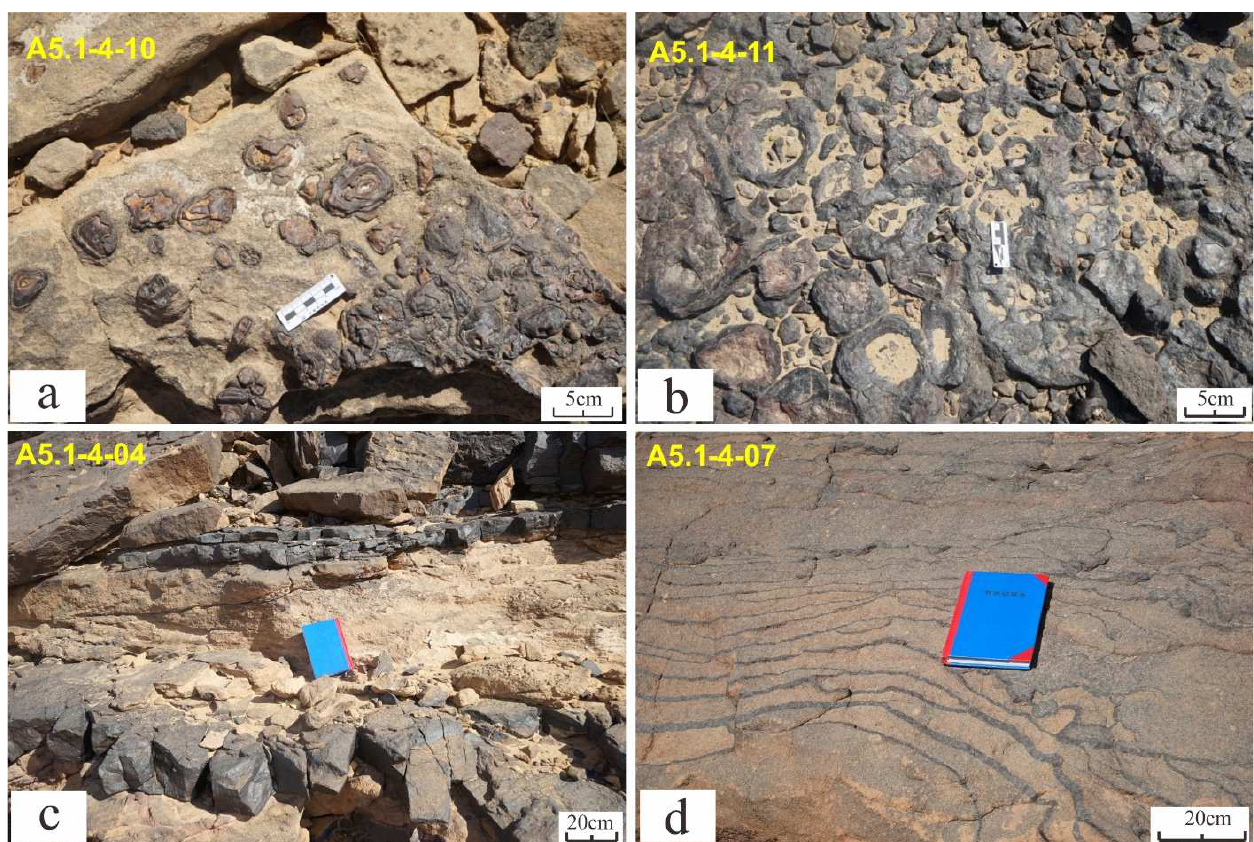
Figure 10. Synsedimentary and later diagenesis ferruginous sandstone in study area. ( a , b ) Ferrugi- nous concretion formed in the sedimentary period with eU content of 30–40 ppm; ( c ) Uranium anomaly in ferruginous sandstone formed in the sedimentary period, 15–30 cm thick, later trans- formed with eU content of 341.74 ppm; ( d ) Ferruginous sandstone formed in later diagenesis pe- riod, 2–4 cm thick, with eU content of 5.2 ppm.